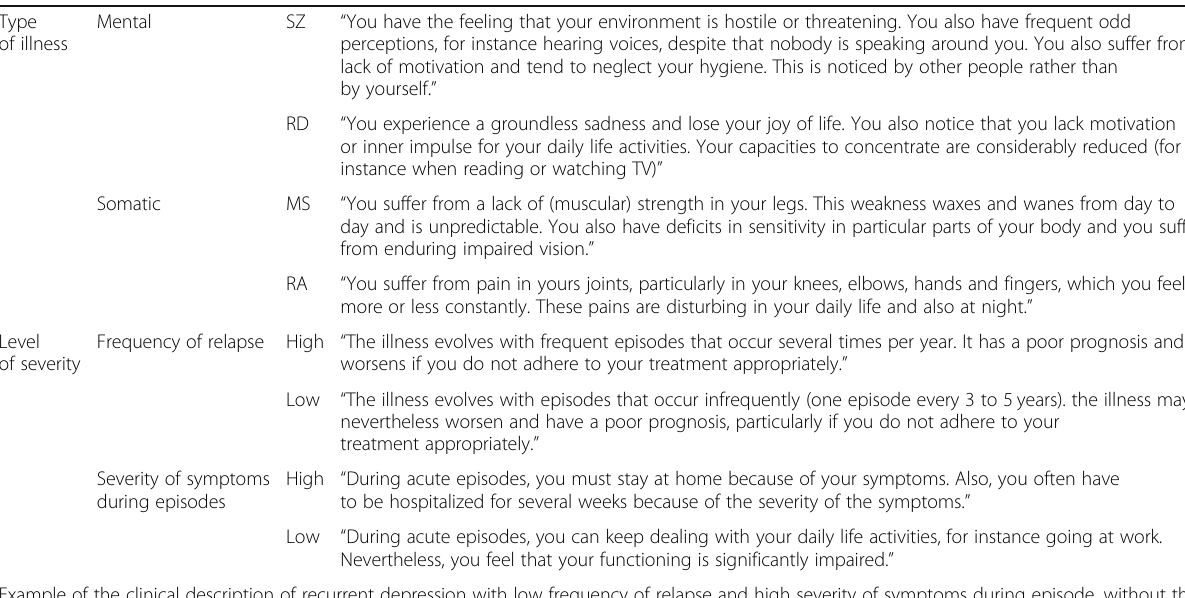
Table 1 Description of the chronic illnesses (SZ: schizophrenia, RD: recurrent depression, MS: multiple sclerosis, RA: rheumatoid arthritis) Type of